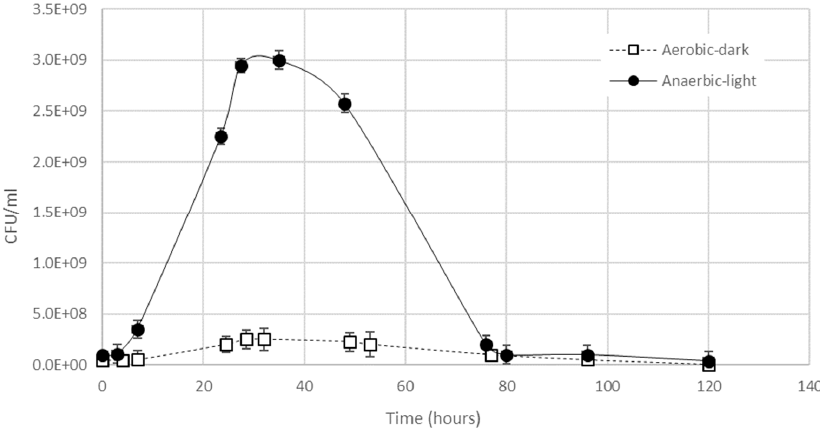
Figure 2. Experimental profile of growth curves for R. capsulatus grown in aerobic ‐ dark and anaerobic ‐ light conditions.